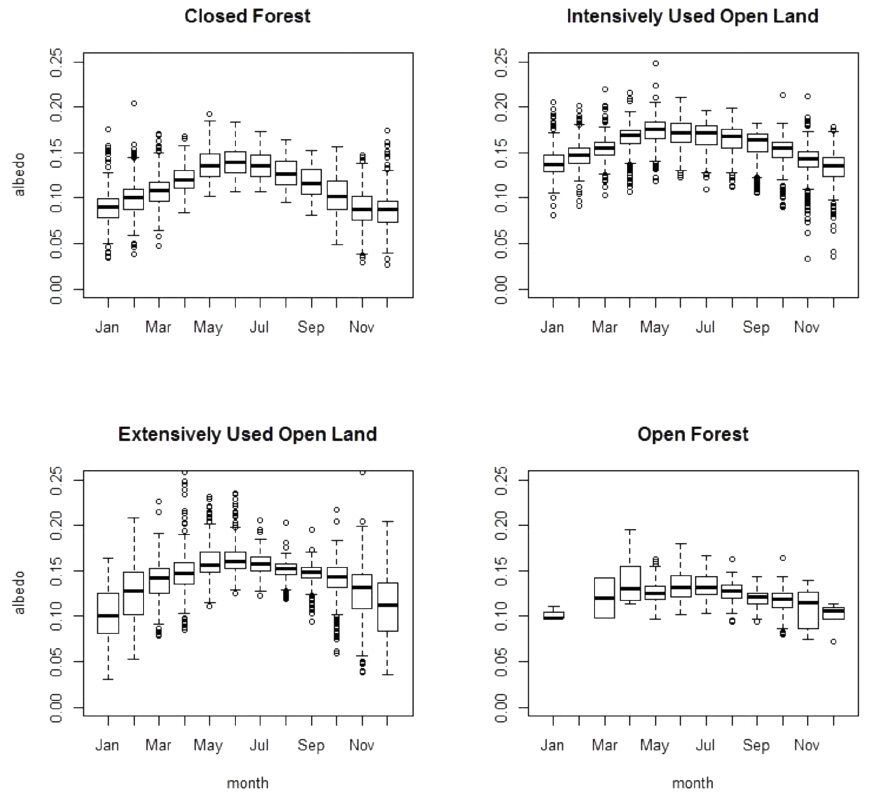
Figure A2. Seasonal variation of albedo values of the four snow-free LULC classes: closed forest, intensively used open land, extensively used open land and open forest (only full BRDF inversion albedo